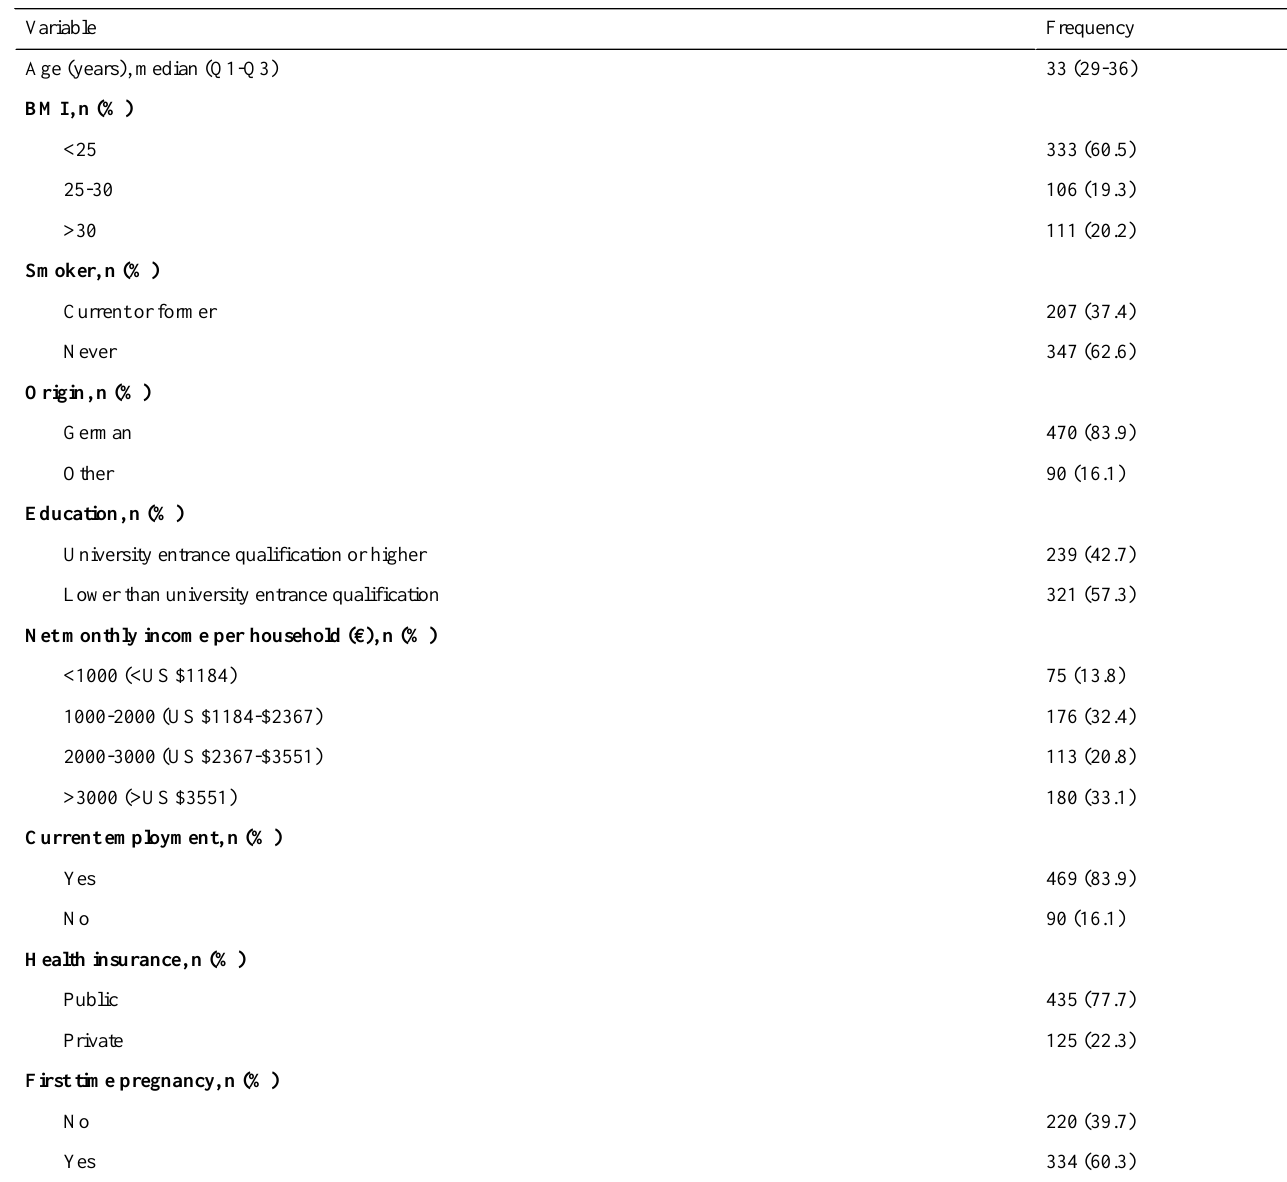
Table 2. Demographic characteristics of the study